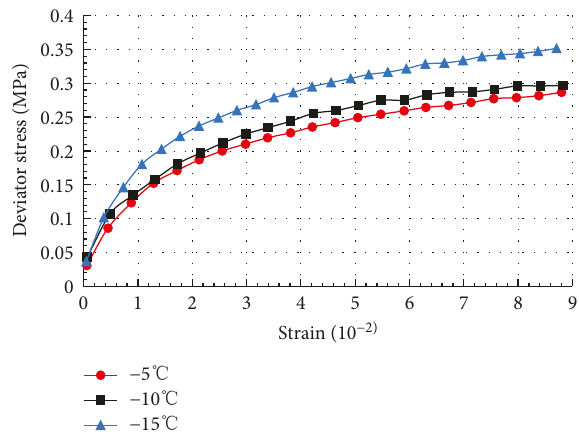
Figure 8: Dynamic stress-strain curve of frozen soil ( f σ 3 0.5 MPa, and A (cid:31)